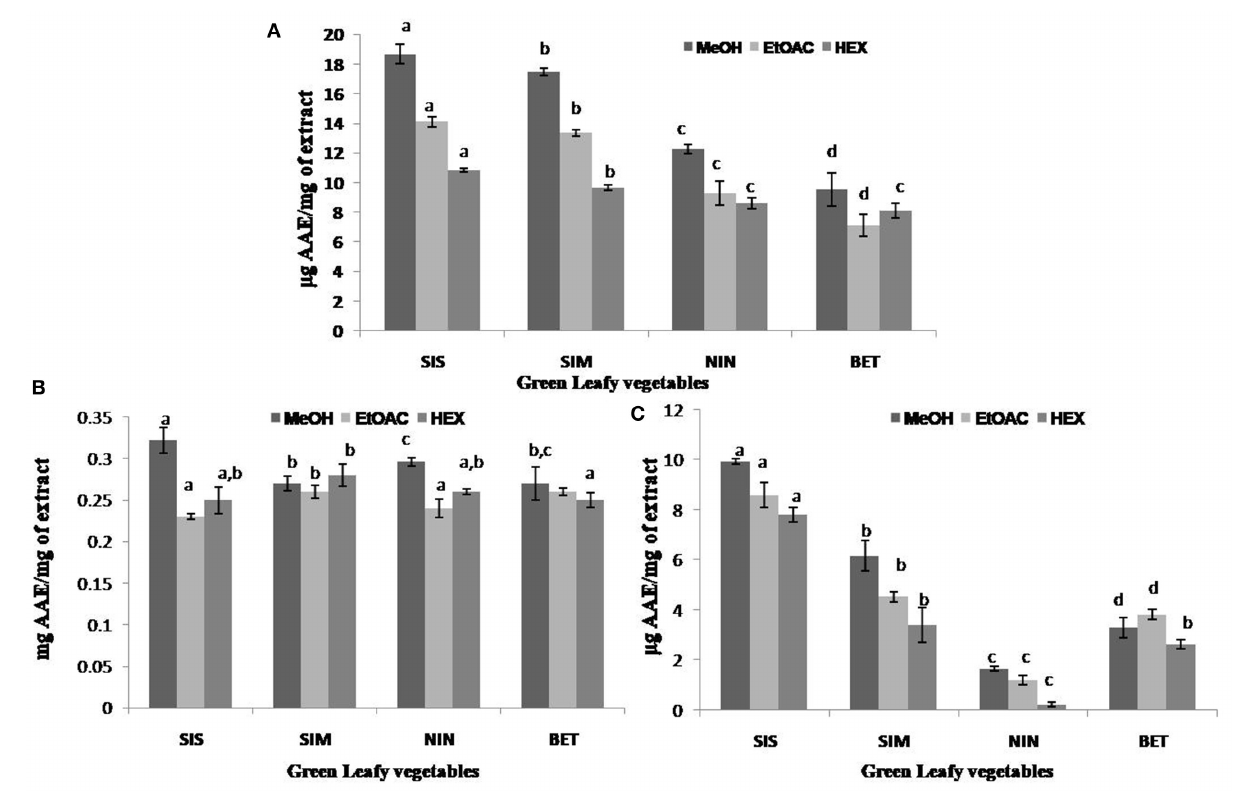
FIGURE 2 | Antioxidant activities of different extracts of selected green leafy vegetables of Sikkim Himalayan region. (A) DPPH radical scavenging activity, (B) total antioxidant activity, and (C) reducing power potential. SIS, Sisnu (Urtica dioica) ; SIM, Simrayo (Nasturtium officinale) ; NIN, Ningro (Diplazium esculentum) ; BET, Bethu (Chenopodium album) ; MeOH, methanolic extract; EtOAC, ethyl acetate extract; HEX, hexane extract. Values not sharing common alphabets within the same pattern are significantly different ( p < 0.05).